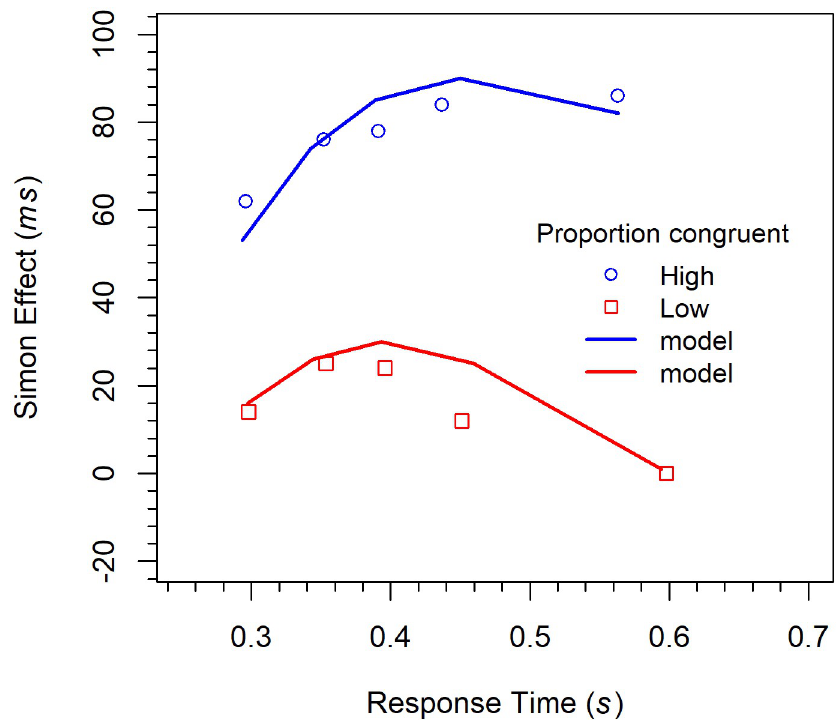
Fig 14. Delta functions for the different conditions in Experiment 3 (Simon task) and the fit (lines) of the DSTP model.